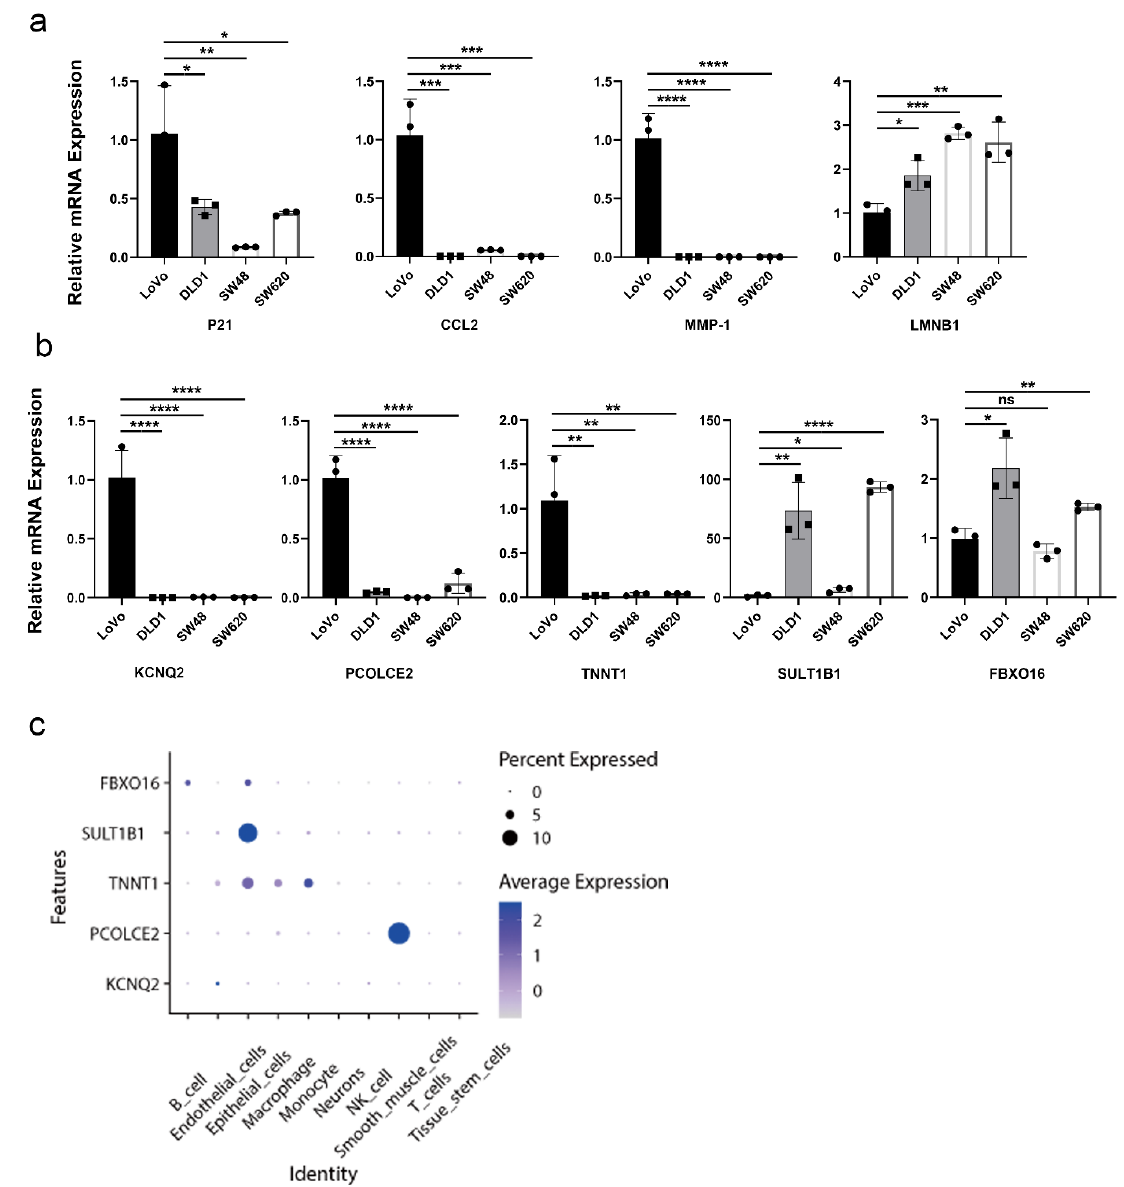
Figure 7. Validation of aging-related genes. ( a ) mRNA expression levels of cellular senescence markers. ( b ) mRNA expression levels of KCNQ2, PCOLCE2, TNNT1, SULT1B1, and FBXO16. ( c ) Dot plot represented the expression of FBXO16, SULT1B1, TNNT1, PCOLCE2, and KCNQ2 of each cell type in CRC tissues. *, p < 0.05; **, p < 0.01; ***, p < 0.001; ****, p < 0.0001; ns, not significant.